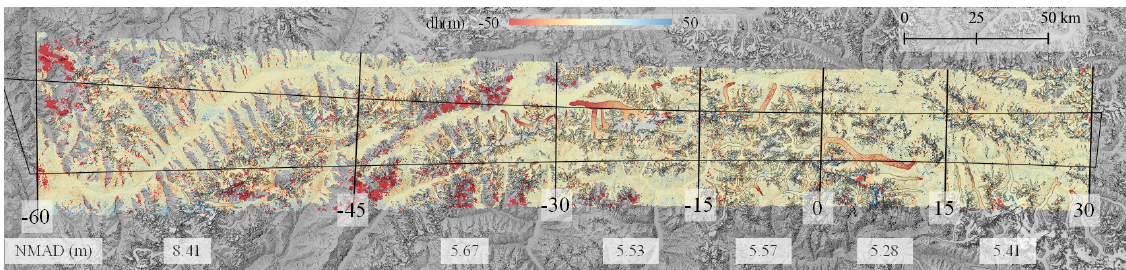
Figure 3. Elevation differences using the entire KH-9 panoramic swath width of successive KH-9PC stereo images (D3C1206-200215F049- F52 and D3C1206-200215A050-A052) and the AW3D30 covering parts of the Karakoram and Hindu Kush mountains. The near-vertical lines show approximate 15 ◦ intervals of the panoramic scan. The NMADs of the elevation differences over stable terrain are shown at the bottom for each 15 ◦ scan area. The footprint of scene D3C1206-200215A051 is overlaid for reference. The part of the DEM beyond 30 and − 60 ◦ scan angles has been clipped. Occlusions due to high relief and slant viewing angle cause data gaps between − 60 to − 35 ◦ scan angles, while some data gaps and outliers are due to clouds (see Fig.